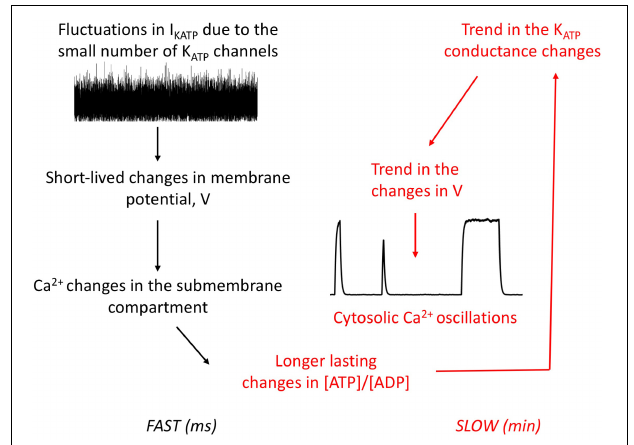
FIGURE 6 | Schematic representation of the interplay between randomness of the K ATP current and ATP changes to generate irregular, slow Ca 2 + oscillations in α -cells. Rapid fluctuations in the K ATP current due to the small number of channels in the α -cell plasma membrane create fluctuations in membrane voltage that can induce a short-lived change in membrane voltage, which in turn modifies submembrane Ca 2 + concentration. If the dynamics of ATP is not considered, this noise-induced change in Ca 2 + would last some milliseconds. If ATP is considered, large fluctuations create a change in ATP concentration of larger duration, because ATP kinetics is much slower than electrical activity. Despite the rapid noise on V that is still present, this will create a trend in the changes in V because of the feedback exerted by ATP on the K ATP current. Thus, periods of quiescence and activity will alternate, which is responsible for cytosolic Ca 2 + oscillations by diffusion of the membrane Ca 2 +